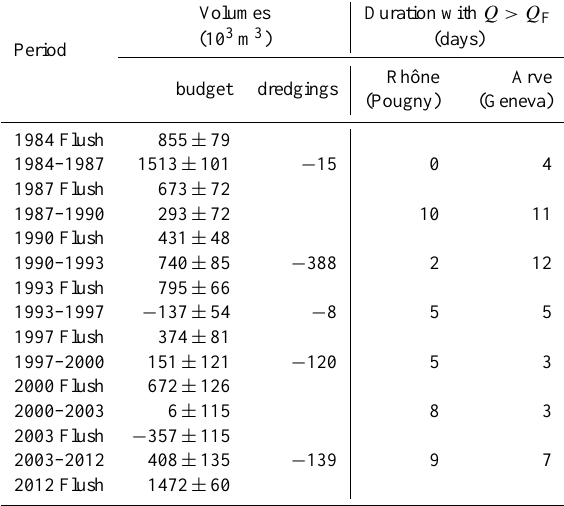
Table 1. Sediment volume budget from 1984 to 2012 (Positive val- ues correspond to deposited volumes and negative ones correspond to eroded volumes. The volume budget includes dredged volumes. Q F is the annual maximum daily River discharge. Q F , Rh ˆ one =